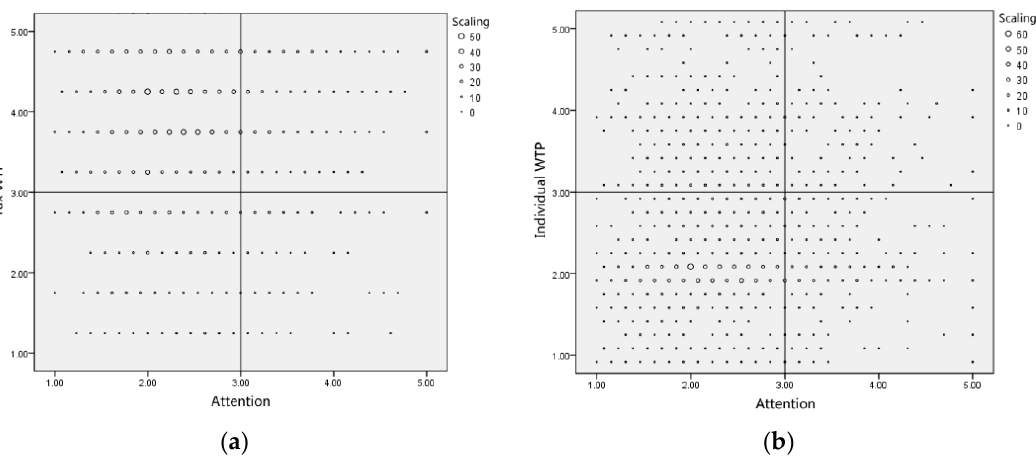
Figure 4. Statistical analysis of public attention and WTP to occupational safety and health. ( a ) Cross statistics of attention and tax WTP; ( b ) Cross statistics of attention and individual income WTP.